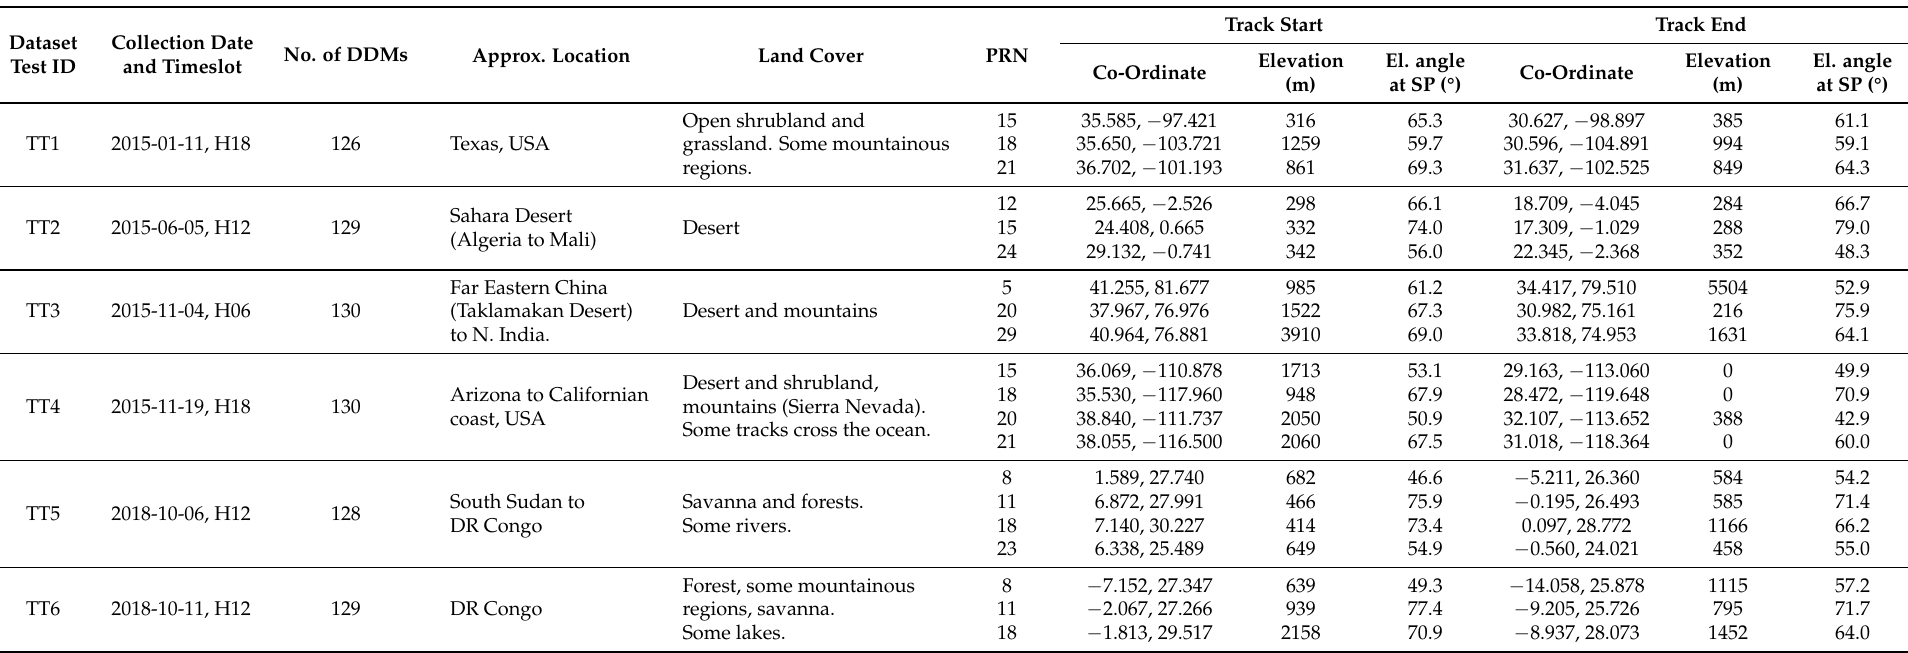
Table 2. Raw TDS-1 datasets used in this